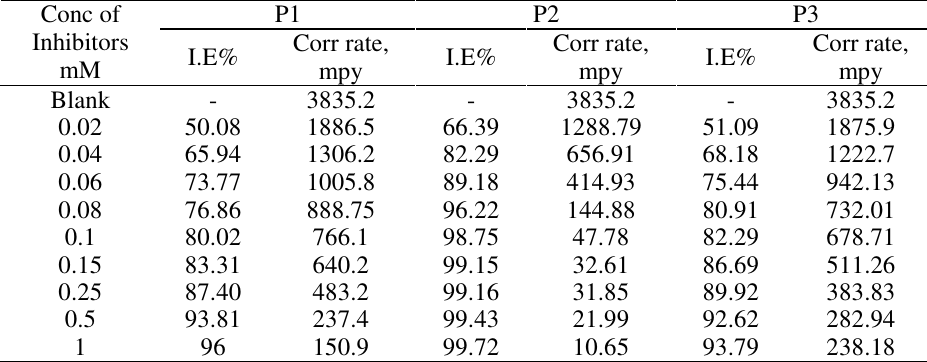
Table 1. Inhibition efficiency (%) of the inhibitors and corrosion rate (mpy) of mild steel in 1 M H SO obtained by weight loss method at 303 K 2 4